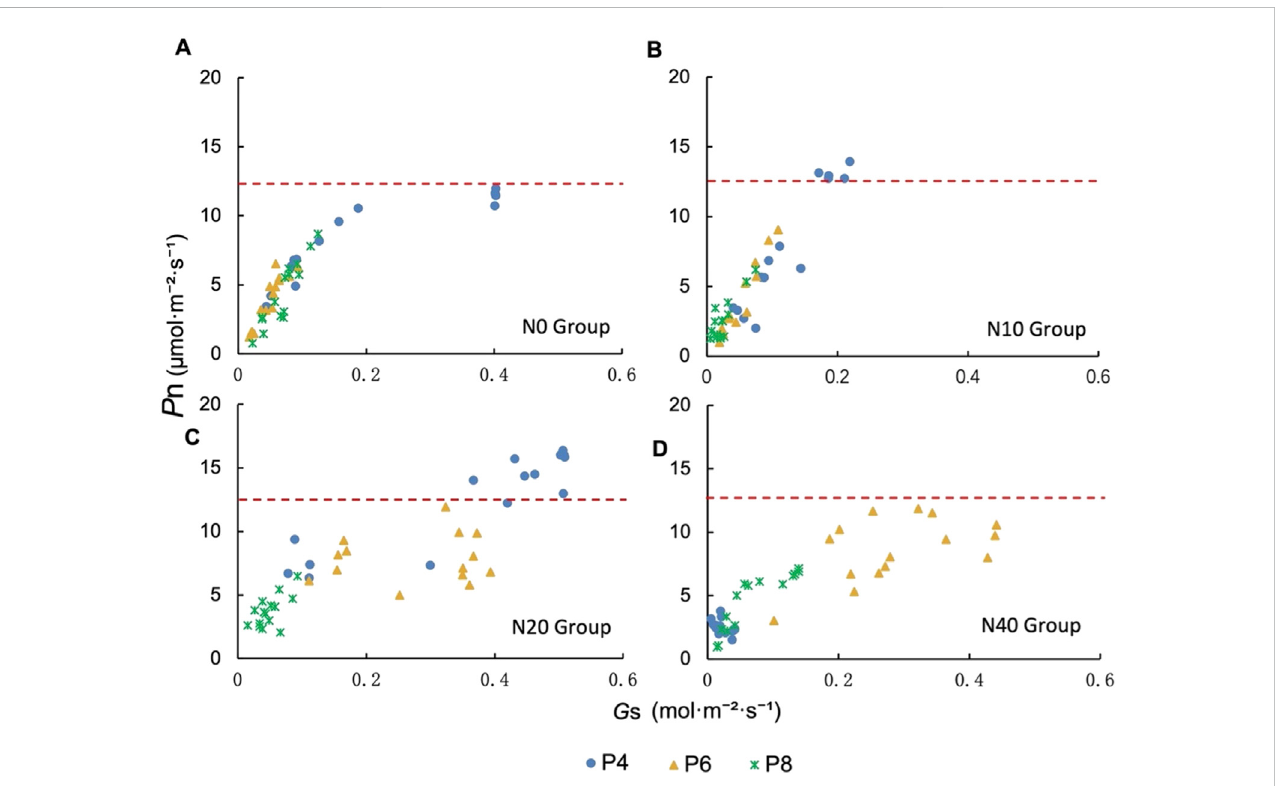
FIGURE 5 Relationship between net photosynthetic rate ( Pn ) and stomatal conductance (Gs) under different N and P addition treatments. (A) N0 group, (B) N10 group, (C) N20 group and (D) N40